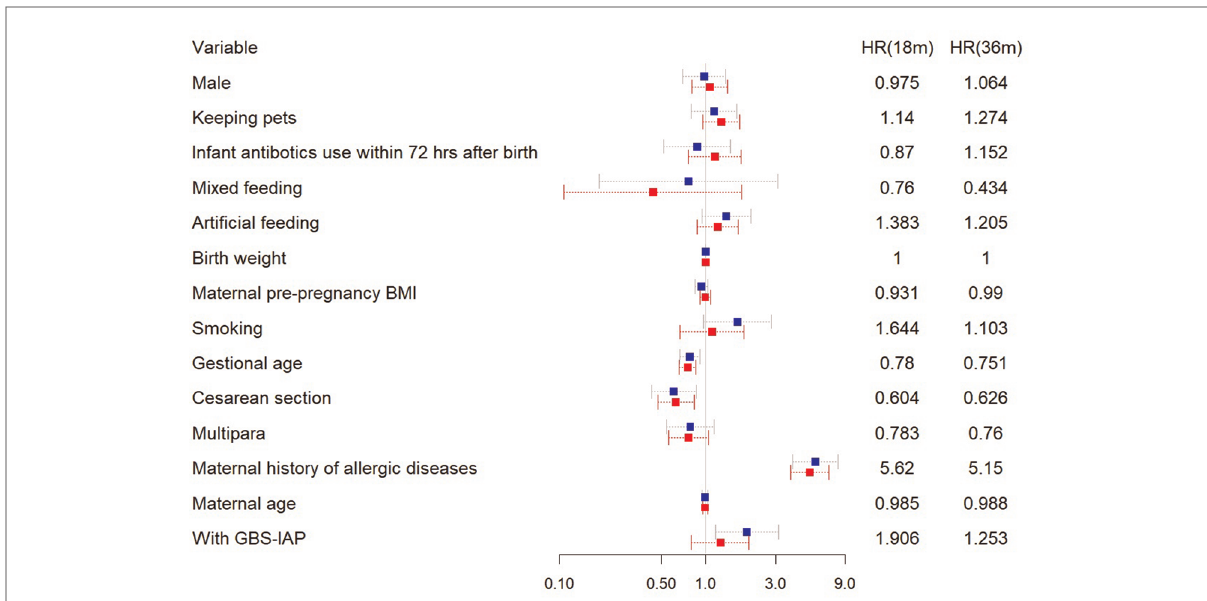
FIGURE 3 Forest plot for multivariate Cox proportional hazards regression analysis of outcomes. HR, hazard ration; GBS, group B Streptococcus; IAP, intrapartum antibiotic prophylaxis; BMI, body mass index. Blue square represents a follow-up of 18 months. and red symbol represents followed- up to 3 years